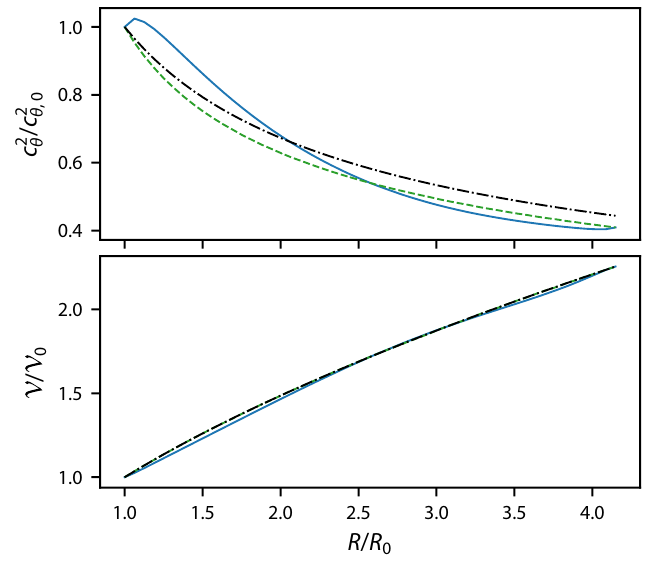
Figure 1: Scalings of azimuthal sound speed squared (top) and volume (bottom) for the instantaneous ground state of the condensate in Ref. [ 19 ] . The dot-dashed curves are for the thin ring limit, without the inertial potential ( c 2 The dashed curves include the ring thickness, while the solid curves include both ring thickness and the inertial